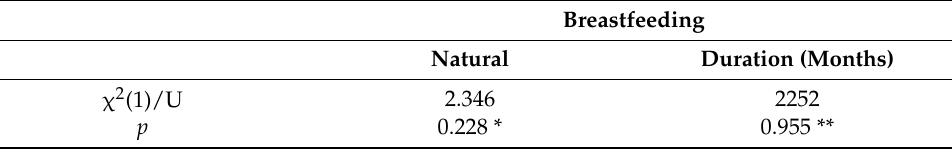
Table 3. Statistical comparisons between DDE and no-DDE groups regarding parameters related to breastfeeding (expressed in